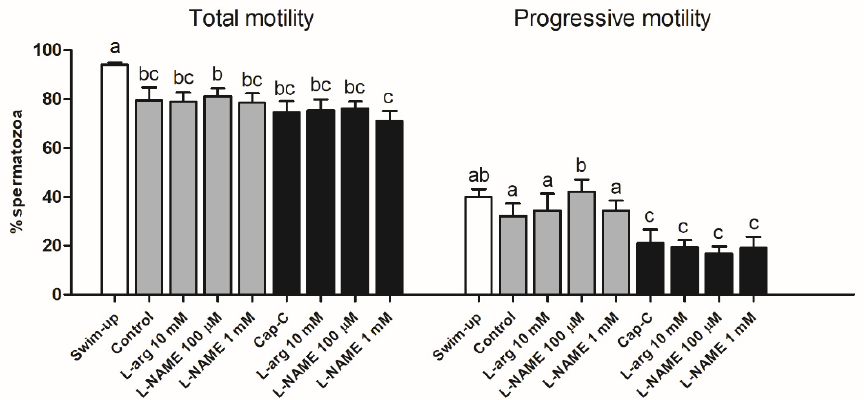
Figure 5. Percentage of total motile (left) and progressive (right) spermatozoa before (swim-up, white bars) and after in vitro capacitation without (control, grey bars) and with cAMP-elevating agents (Cap-C, black bars) and with L-arginine (L-arg, 10 mM) or L-NAME (100 µM or 1 mM). Data are shown as mean ± S.E.M. ( n = 5). Different letters indicate significant differences ( p < 0.05).